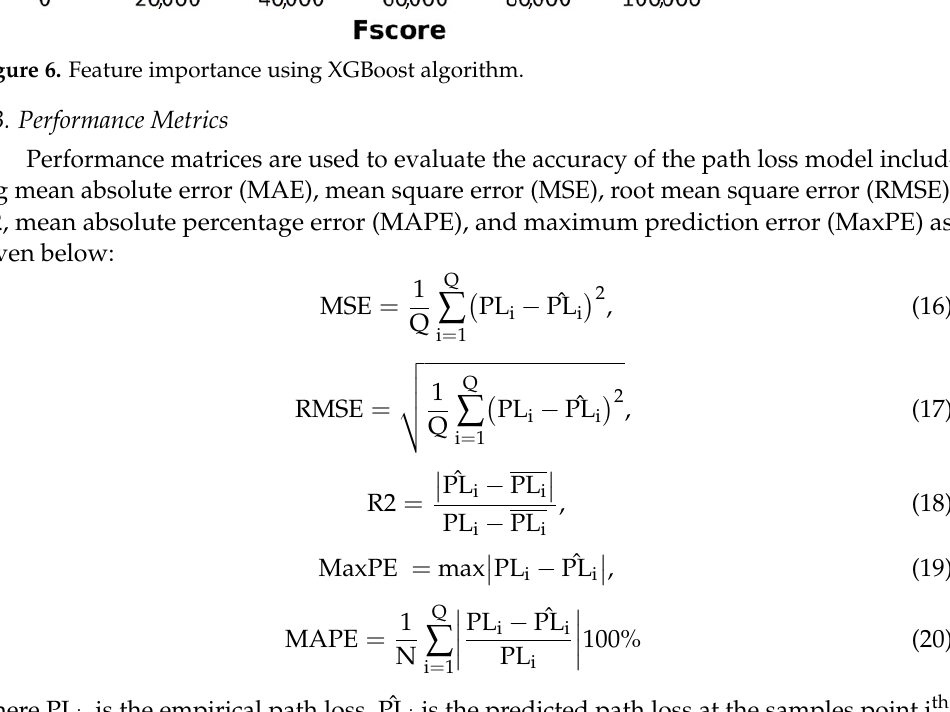
Figure 6. Feature importance using XGBoost algorithm.